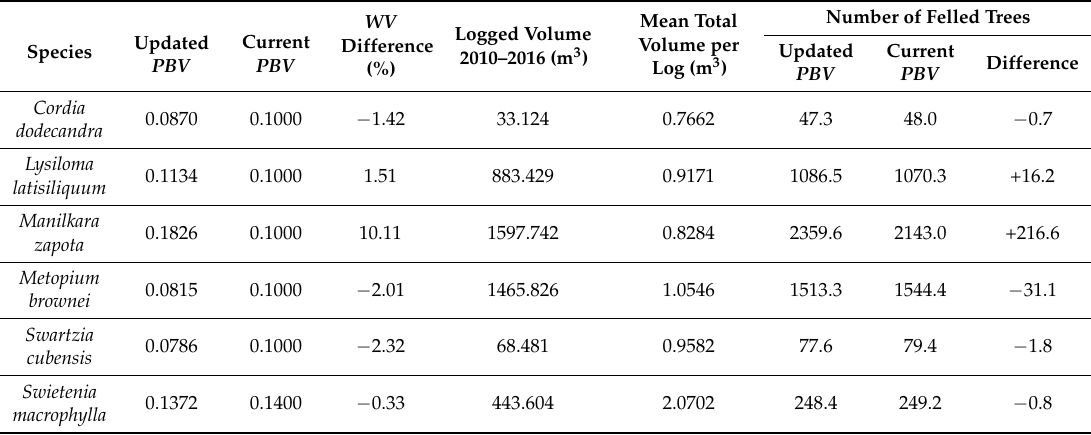
Table 5. Proportion of bark volume calculated here (updated PBV ) and currently used by the Ejido Felipe Carrillo Puerto (current PBV ), and the difference in the number of trees that would need to be felled using the current PBV vs. the updated PBV considering the wood volumes ( WV ) sold from 2010 to 2016 by the ejido. Mean total volume per log was calculated based on the data measured in this